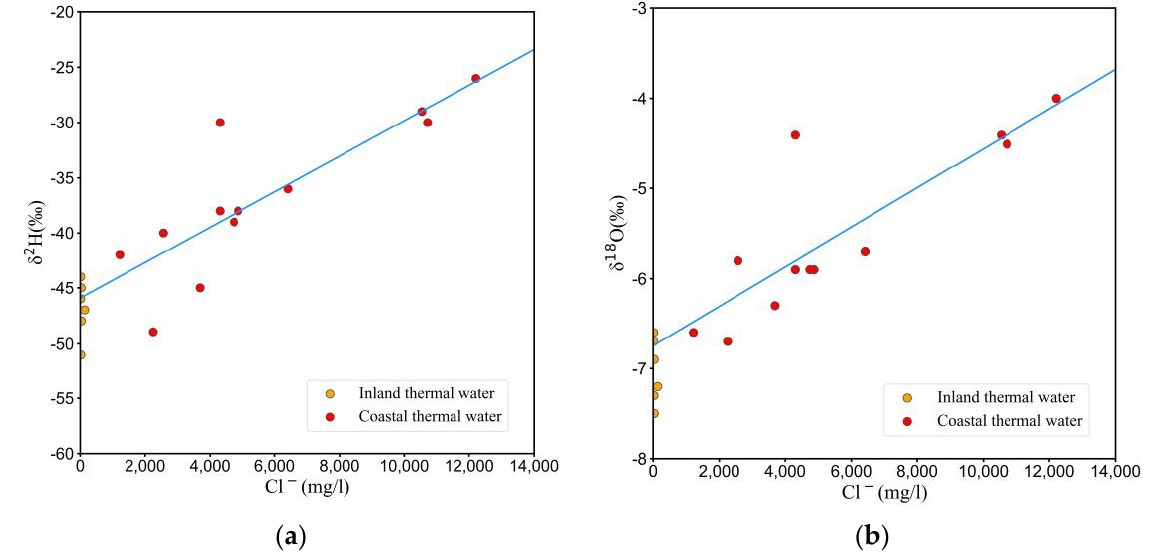
Figure 4. Cl - - δ 2 H ( a ), Cl - - δ 18 O ( b ); correlation of geothermal water in southeastern China. Figure 4. Cl − - δ 2 H ( a ), Cl − - δ 18 O ( b ); correlation of geothermal water in southeastern